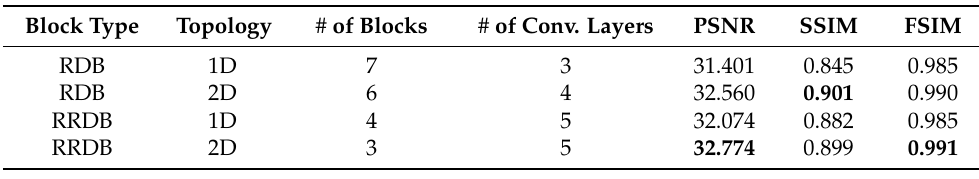
Table 1. The best results of four combinations used to replace the original block in the UDSN, where the best results are shown in boldface.